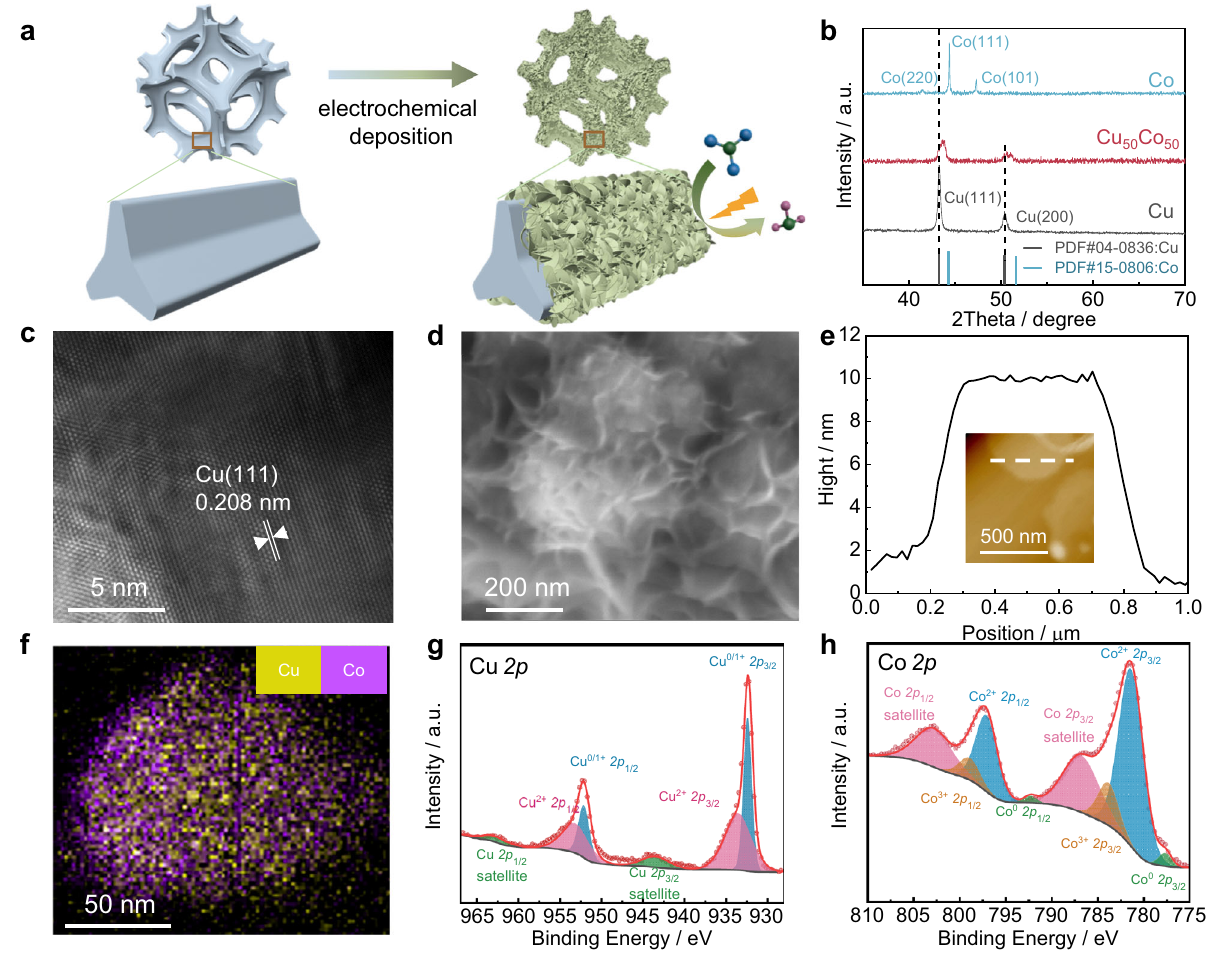
Fig. 1 | Preparation strategy and characterization of catalysts. a Schematic diagramofCuCoalloyelectrodepositiononnickelfoam ’ ssurface. b XRDspectraof Cu 50 Co 50 ,Cu,andCo.HRTEMimage( c ),SEMimage( d ),lineartopographypro fi les